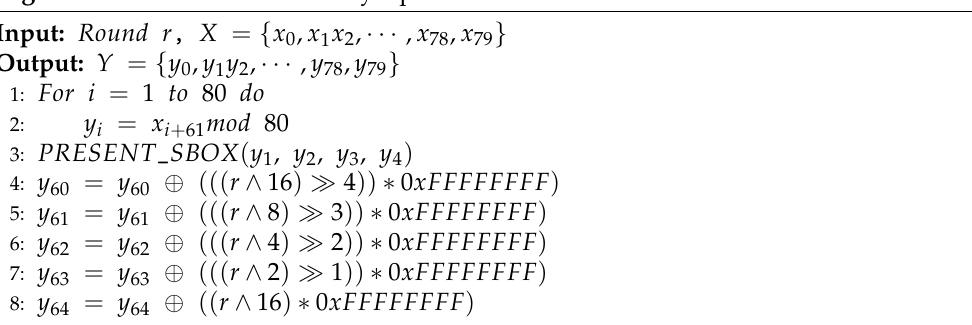
Algorithm 2 PRESENT RoundKey